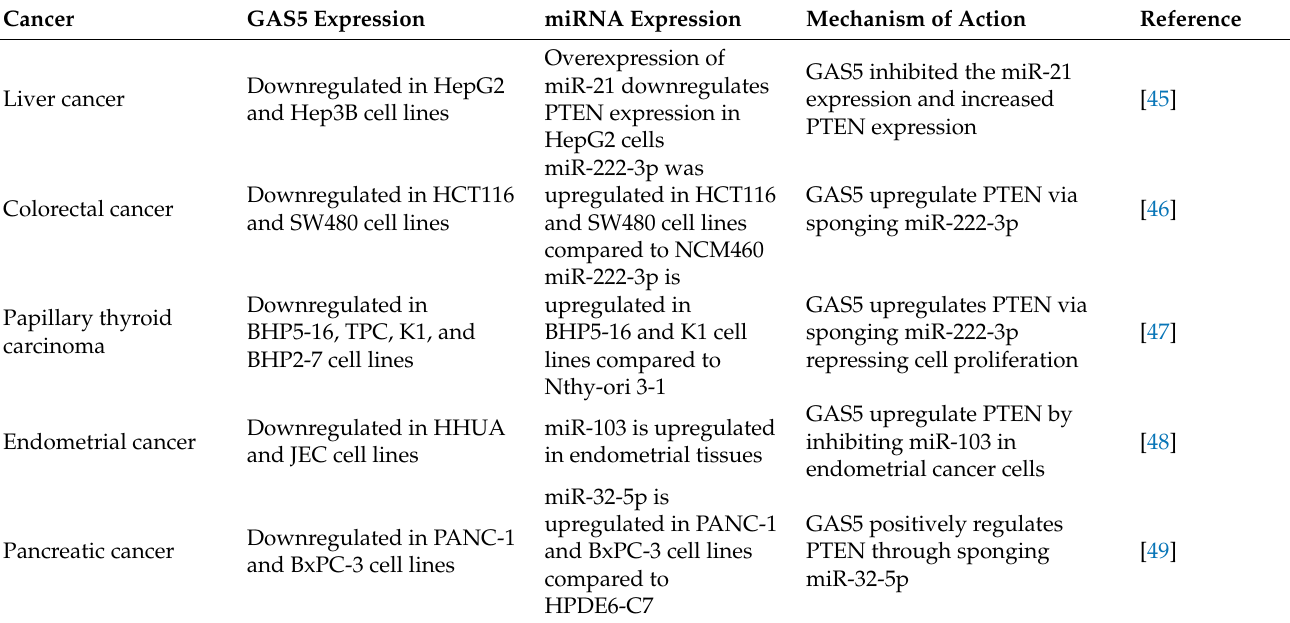
Table 1. GAS5 regulates PTEN expression via acting as a molecular